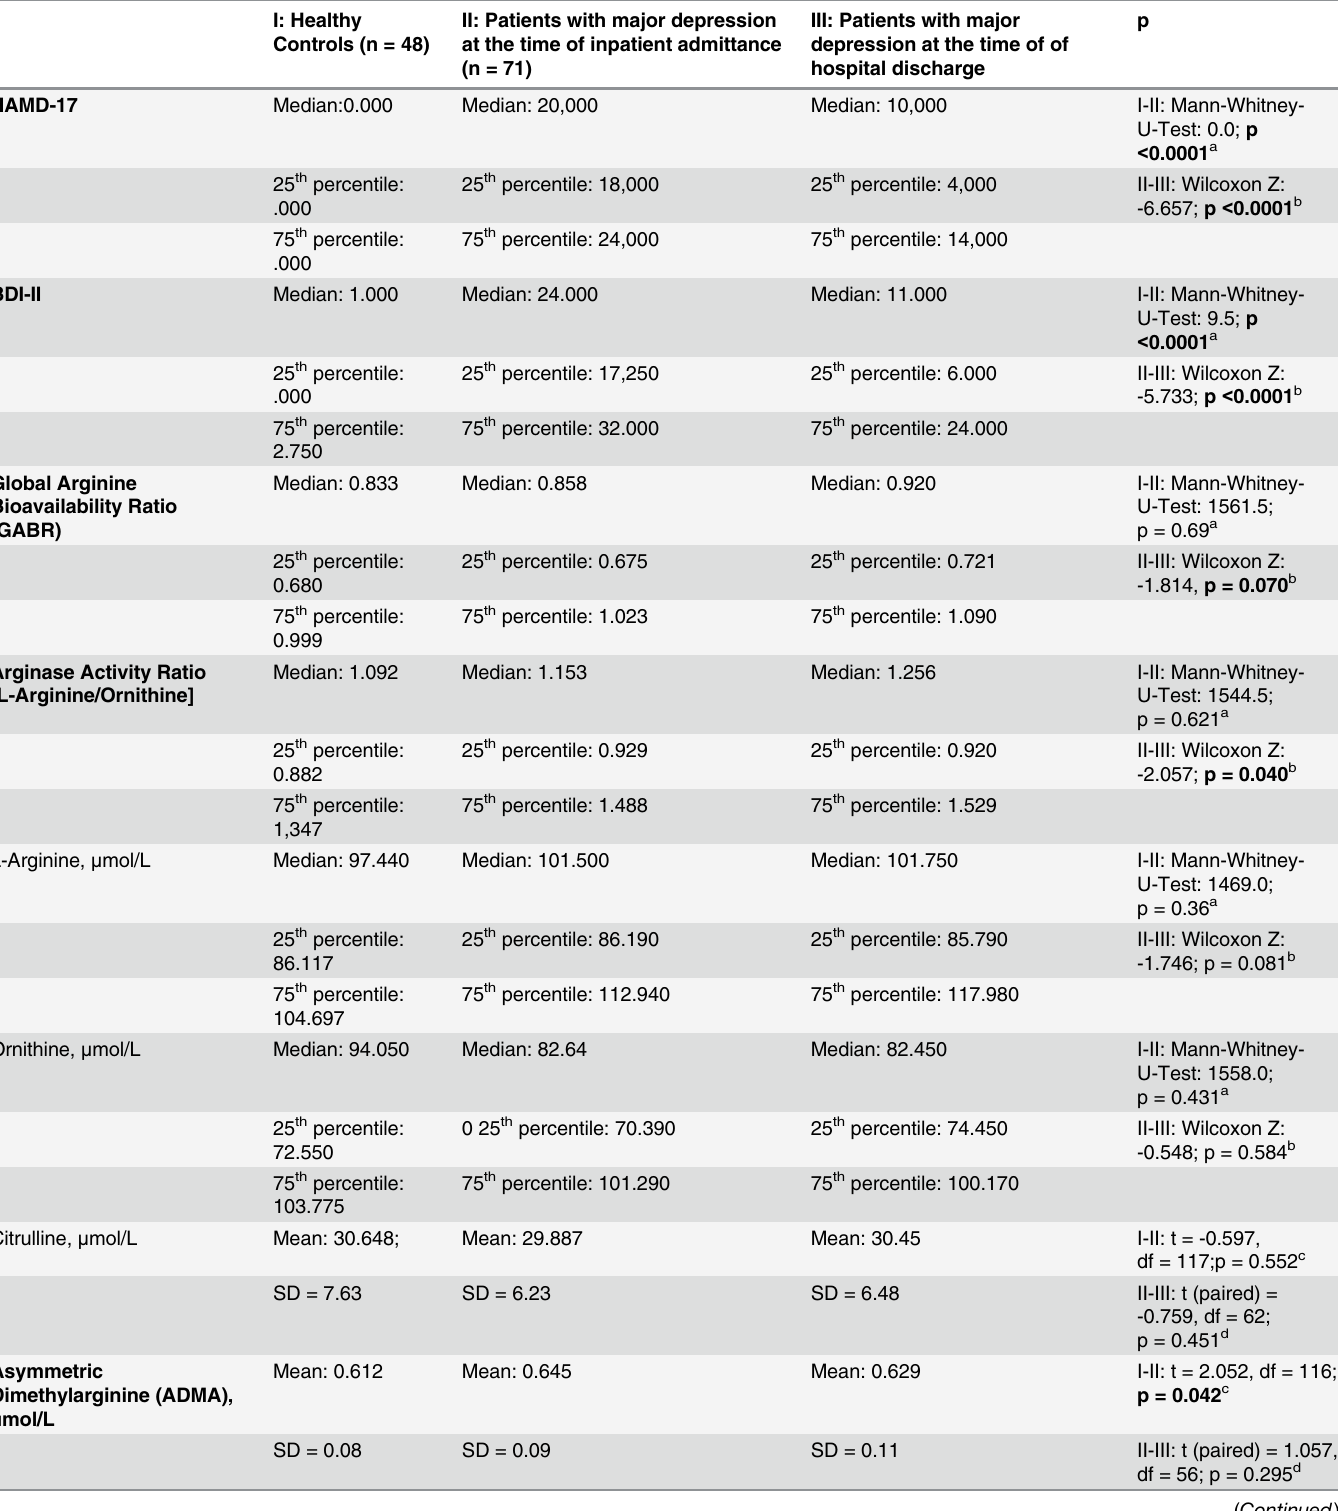
Table 2. Biological assessments and psychometric tests for the patients with major depression at the time of inpatient admittance, at the time of hospital discharge and for the healthy